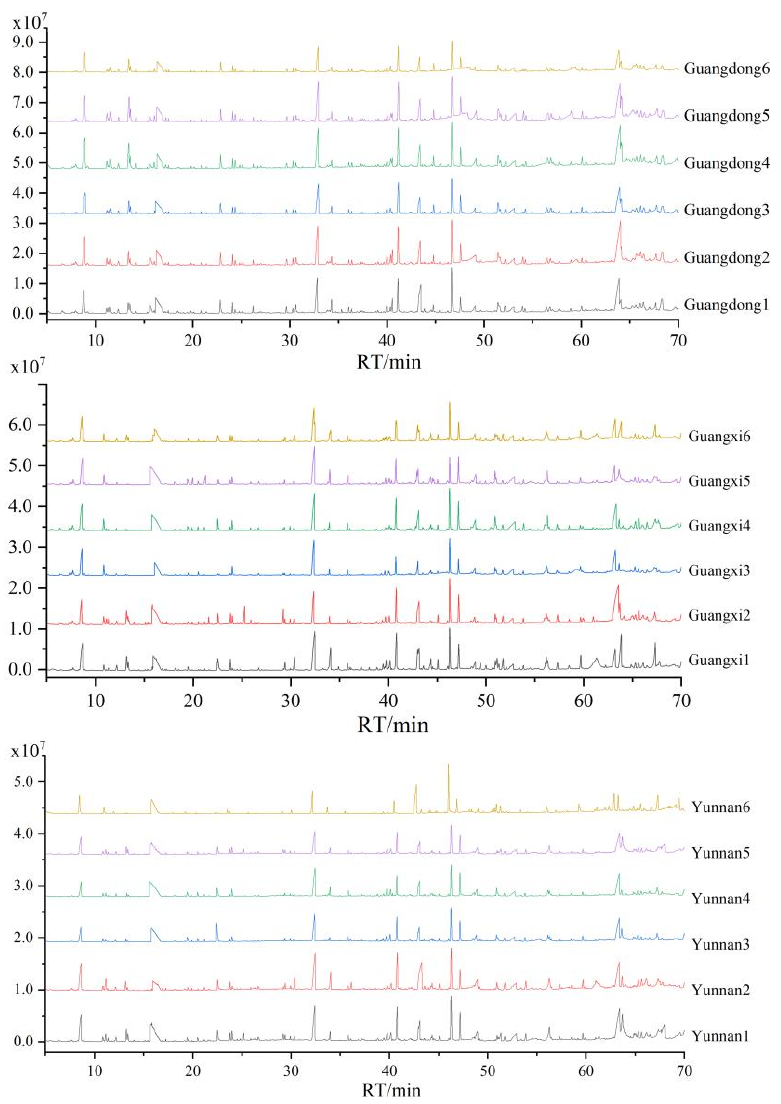
Figure 2. Fingerprint of brown sugar from Guangdong, Guangxi and Yunnan. The cosine of the included angle of six samples in Guangxi was above 90%, and the similarity of Guangxi3 was just less than 90% (89.80%). This result indicated that the odor properties of these six samples in Guangxi were similar, without much difference Of the six samples in Yunnan, only Yunnan2 had similarity and cosine of included angle lower than 90%, while the other five samples had similarity and cosine of included an- gle higher than 90%. This result indicated that the odor attributes of the other five samples were similar, but Yunnan2 had significant differences with